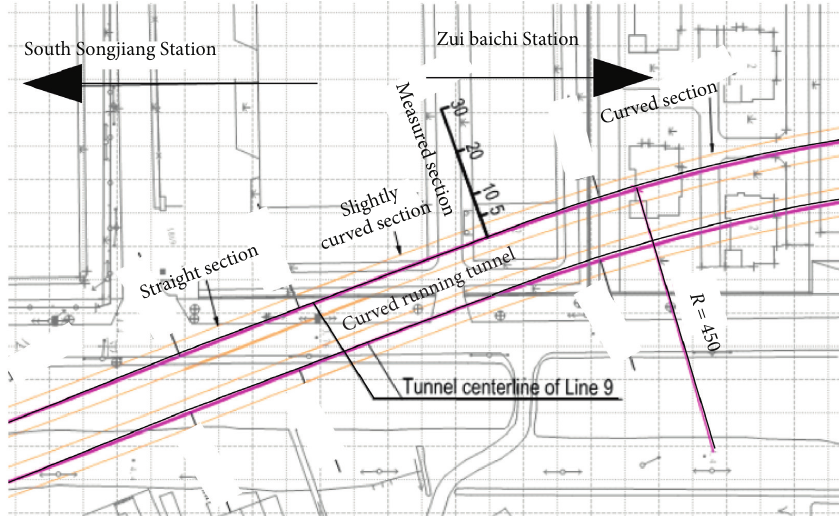
Figure 1: Planar view of the measured site.